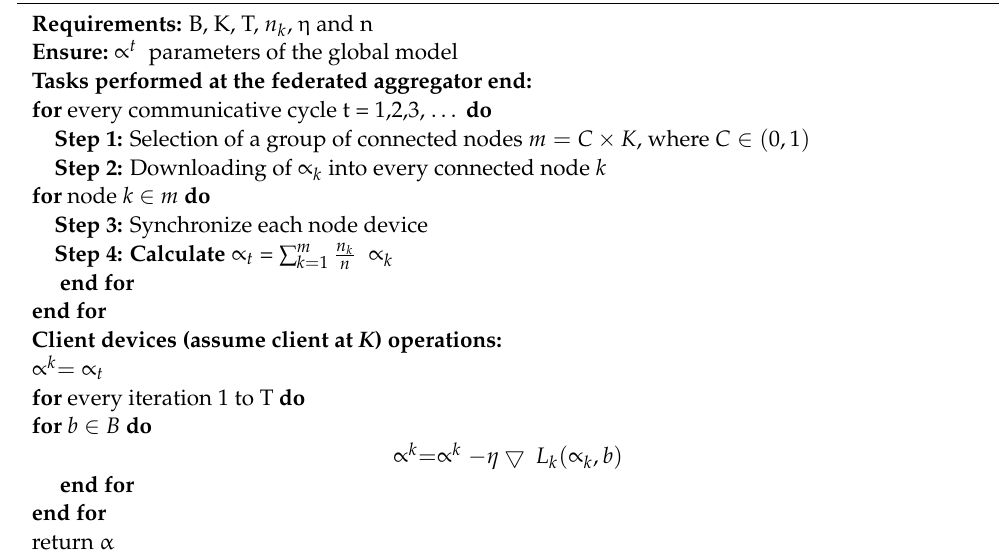
Algorithm 2. Federated aggregative model inspired by the FedAvg method for K client